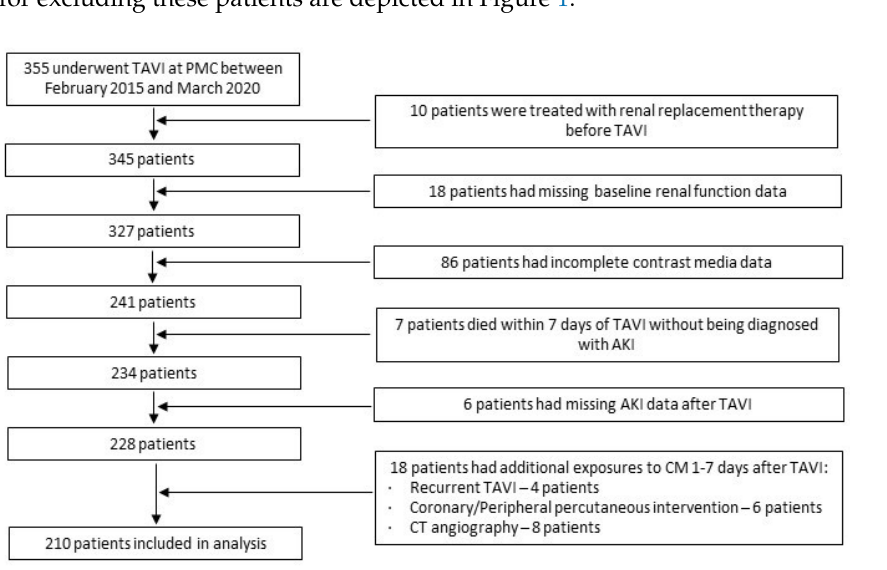
Figure 1. Patient selection flow chart.